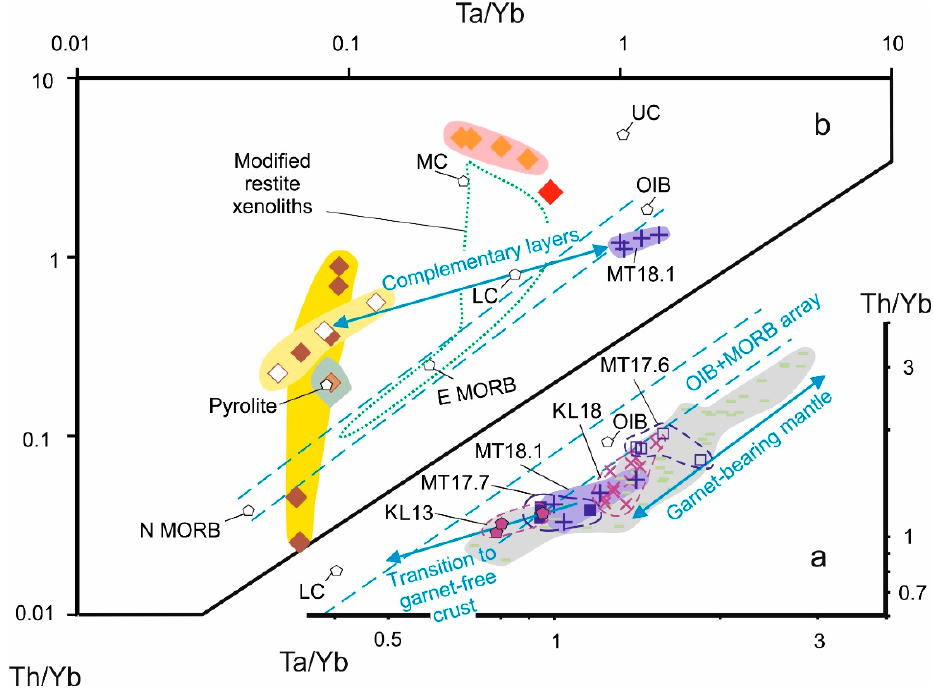
Figure 12. Th/Yb-Ta/Yb diagrams of the initial basalts from the Meteo Volcano erupted about 18.1 Ma (MT18.1) in comparison with other volcanic rocks from the KSZHT ( a ) and with pseudotachylytes from the MSF ( b ). On the diagram b , a data field of peridotite nodules from trachybasalts of the Karerny volcano is shown as a possible source of the KSZHT melts after [60]. Additional abbrevia- tions: N MORB and E MORB—normal and enriched basalts of the mid-ocean ridge, respectively [88], LC, MC, and UC—lower, middle, and upper crust, respectively [89]. Symbols are as in Figure 9.